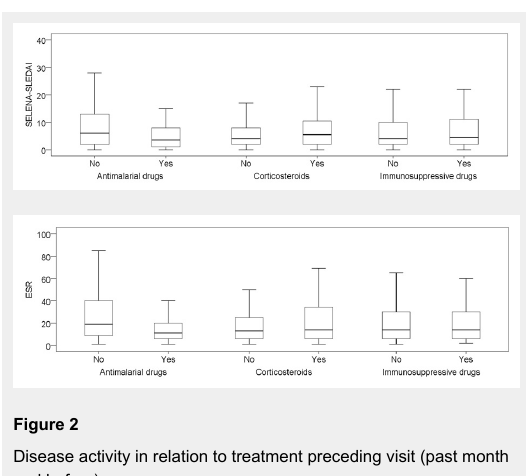
Disease activity in relation to treatment preceding visit (past month and